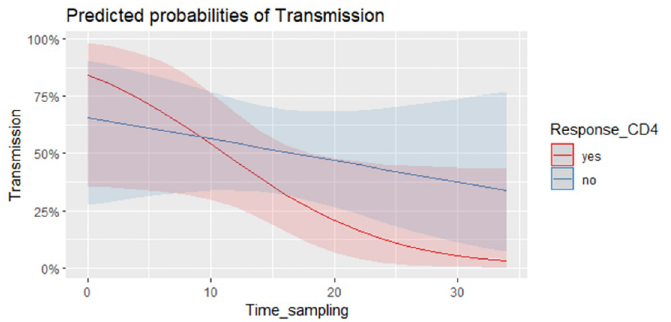
Fig 4. CMV-CD4+IFN- γ lymphocytes relation with time between infection to blood sampling. Model showing the time interval from infection to blood sampling against the predicted probability of CMV intrauterine transmission in women presenting a positive CD4 response (% of CD8-g-IFN producers above 0.1 in red) or not (in blue).